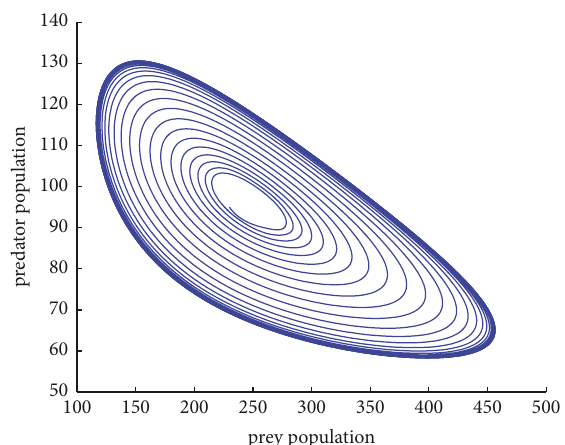
Figure 17: The phase portrait of delayed model (3) with the time delays 𝜏 1 = 0 and 𝜏 2 = 1.5 . The parameters are taken as 𝑥(0) = 230 , 𝑦(0) = 95 , 𝐴 = 0.01 , 𝑟 = 2.65 , 𝐾 = 900 , 𝑎 = 0.02 , 𝑐 = 0.215 , and 𝑚 = 1.06 ; 𝐸 = (𝑥 ,𝑦 ) becomes unstable; a limit cycle is formed. ∗ ∗ ∗